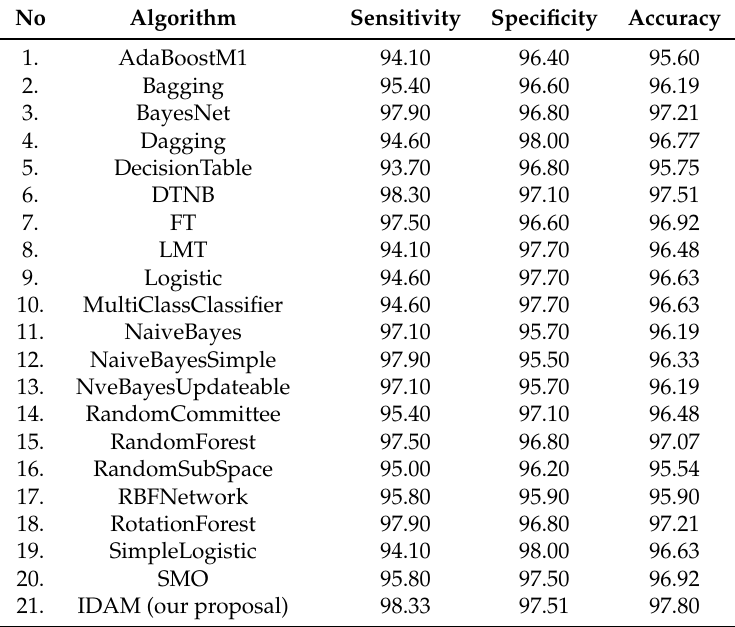
Table 2. Classification accuracy using e-Health Sensor Platform Dataset. Algorithms are presented in alphabetical